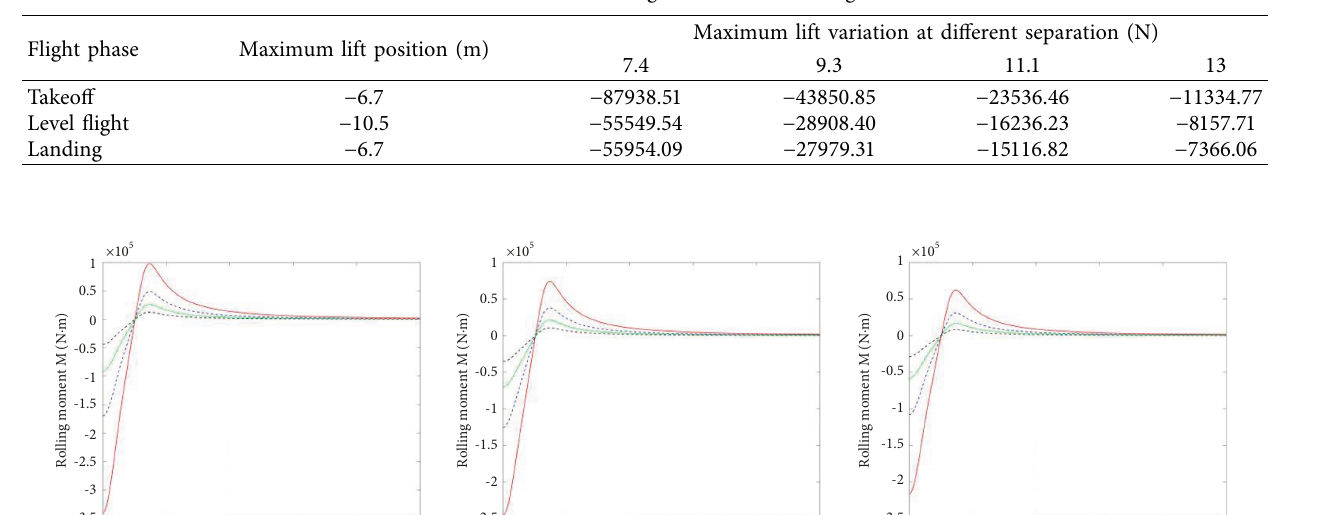
Table 6: Maximum lift variation of longitudinal encountering double